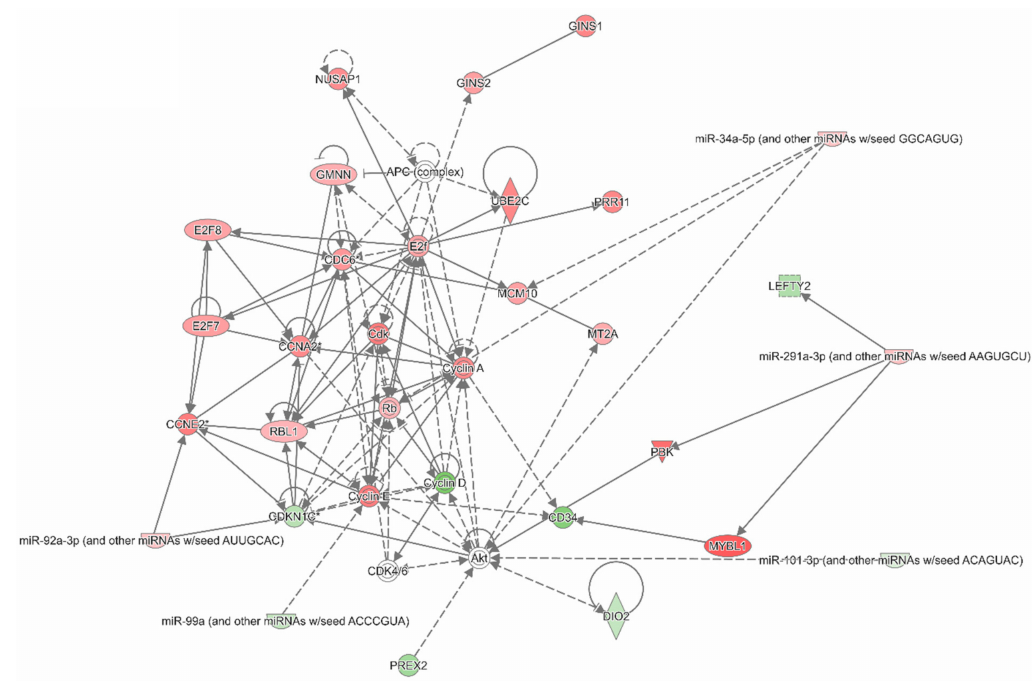
Figure 5. Ingenuity Pathway Analysis integrating di ff erentially expressed genes and microRNAs between imatinib-naïve (IM-n) and imatinib-resistant (IM-r) gastrointestinal stromal tumor (GIST) samples. As input for an Ingenuity Pathway Analysis (IPA) the significantly di ff erentially expressed transcripts (352 genes, p < 0.008, False Discovery Rate (FDR) < 10%) and miRNAs (88 miRNAs, p < 0.03, FDR < 30%) from the same set of IM-r (n = 15) and IM-n (n = 14) GIST samples were used. The depicted network indicates miRNA–gene interactions relevant in context of the cell cycle. Green and red shading indicates relatively low and high expression in the IM-r samples. See Table S5 for an extended symbol